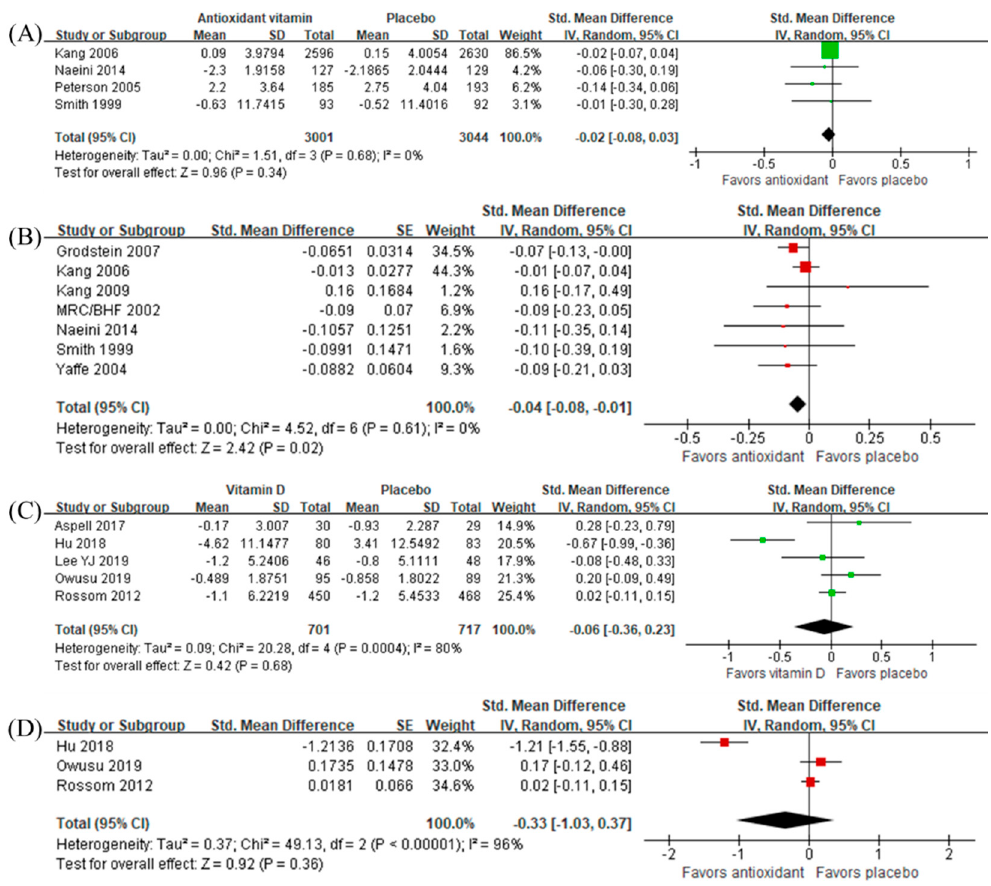
Figure 4. E ff ect of antioxidant vitamins on global cognition in terms of ( A ) change from baseline and Figure 4. Effect of antioxidant vitamins on global cognition in terms of (A) change from baseline and ( B ) final measurement, and the e ff ect of vitamin D on global cognition in terms of ( C ) change from (B) final measurement, and the effect of vitamin D on global cognition in terms of (C) change from baseline and ( D ) final baseline and (D) final measurement.